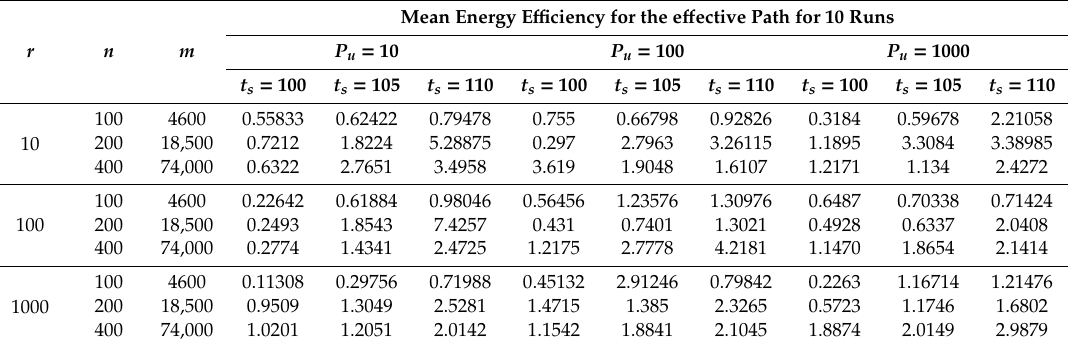
Table 10. Mean energy e ffi ciency for the e ff ective path for the SESE algorithm for 1 Mb .